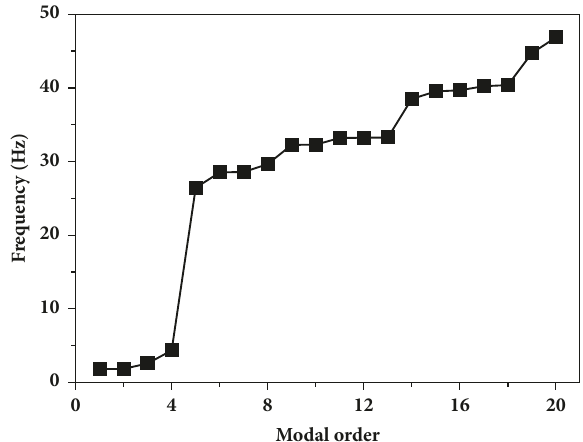
Figure 15: Distribution of natural vibration frequency.